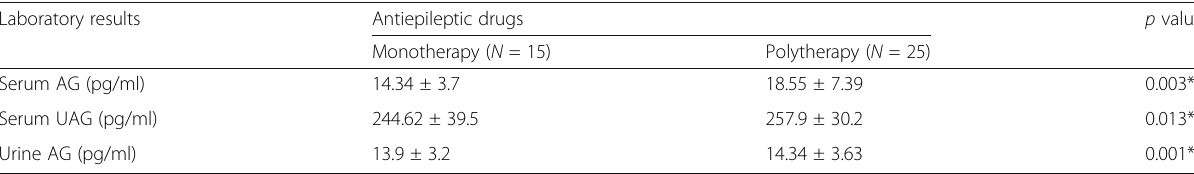
Table 3 Relation between laboratory results and antiepileptic drugs Laboratory